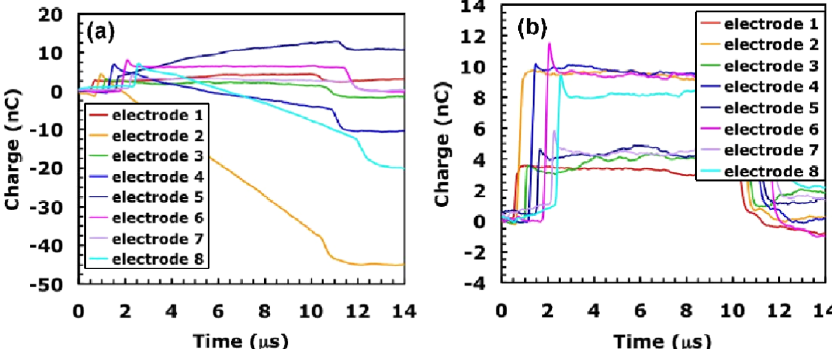
FIG. 13. (Color) Comparison of the charge collected on the electron cloud diagnostics for the: (a) apertured 26-mA beam and; (b) 45- mA beam; both for the clearing case (note scale differences).